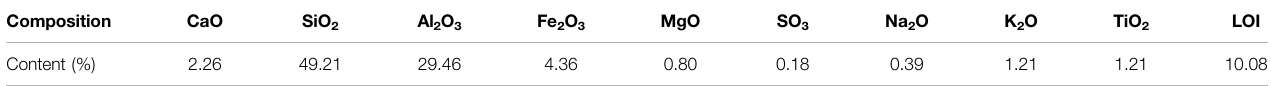
TABLE 1 | Chemical composition of fl y ash.